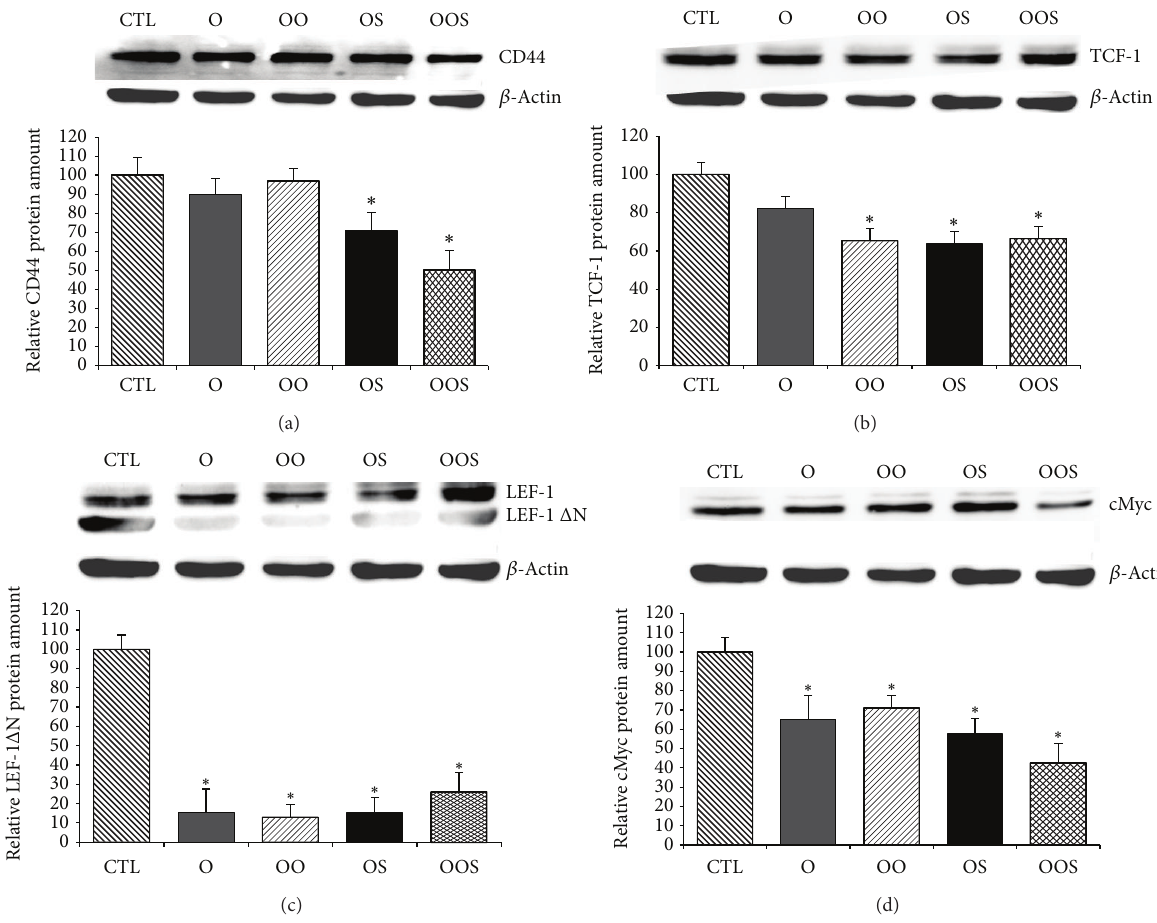
Figure 3: Western blot analysis of Wnt target genes protein expression (a) CD44, (b) TCF-1, (c) LEF-1 Δ N, and (d) cMyc in Saos-2 osteoblastic cells grown as described in Figure 1. In each panel, upper row is the target gene and lower panel is loading control ( 𝛽 actin). Graph depicts protein quantification from Western blot evaluation. Bars represent mean ± SE of three different independent experiments performed in duplicate. ∗ 𝑃 < 0.05 versus CTL; § 𝑃 < 0.05 versus